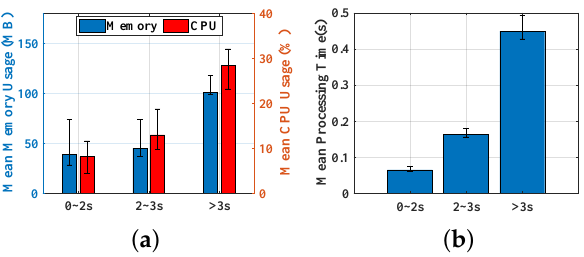
Figure 16. Computational overhead. ( a ) CPU and memory usage across different sample sizes. ( b ) Comparison of the processing times across various sample